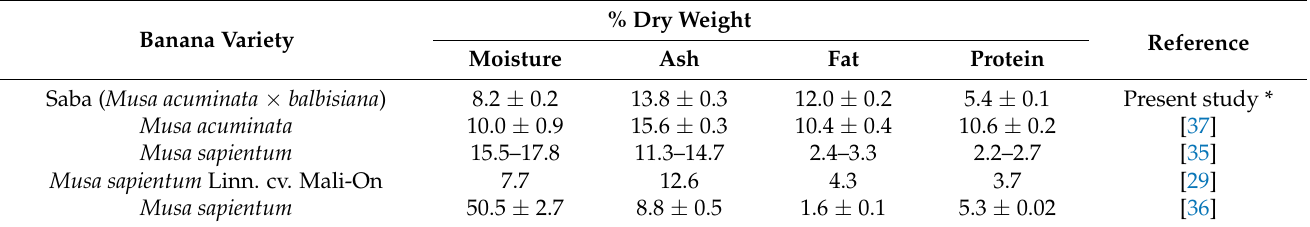
Table 1. Proximate compositions of BP powder.